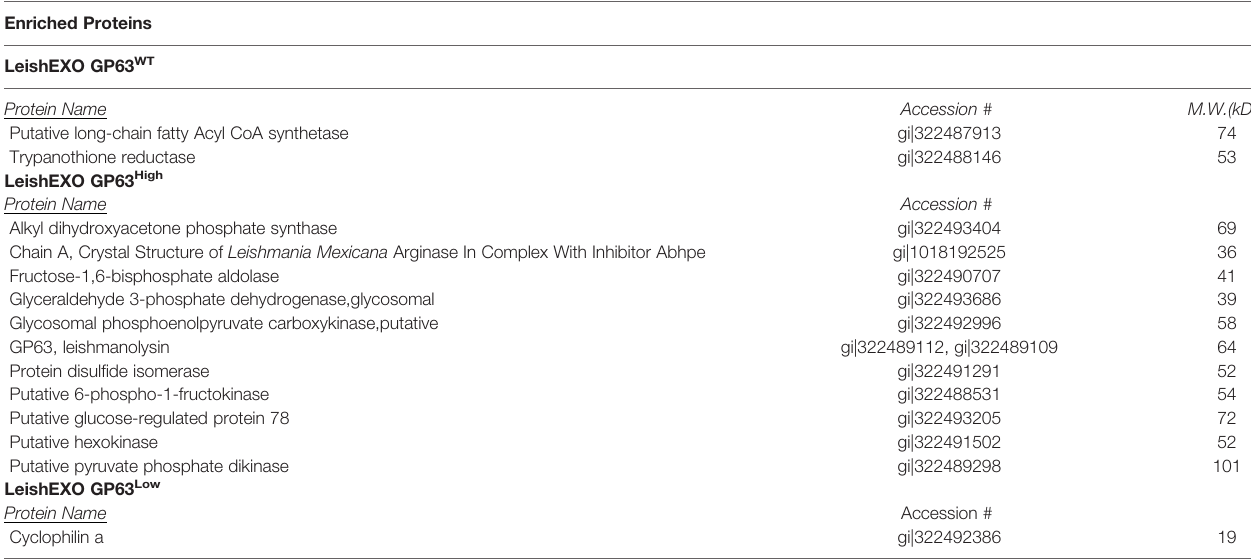
TABLE 2 | Enriched proteins of Leishmania amazonensis GP63 WT , GP63 High, and GP63 Low -derived EVs detected by Mass Spectrometry. Enriched